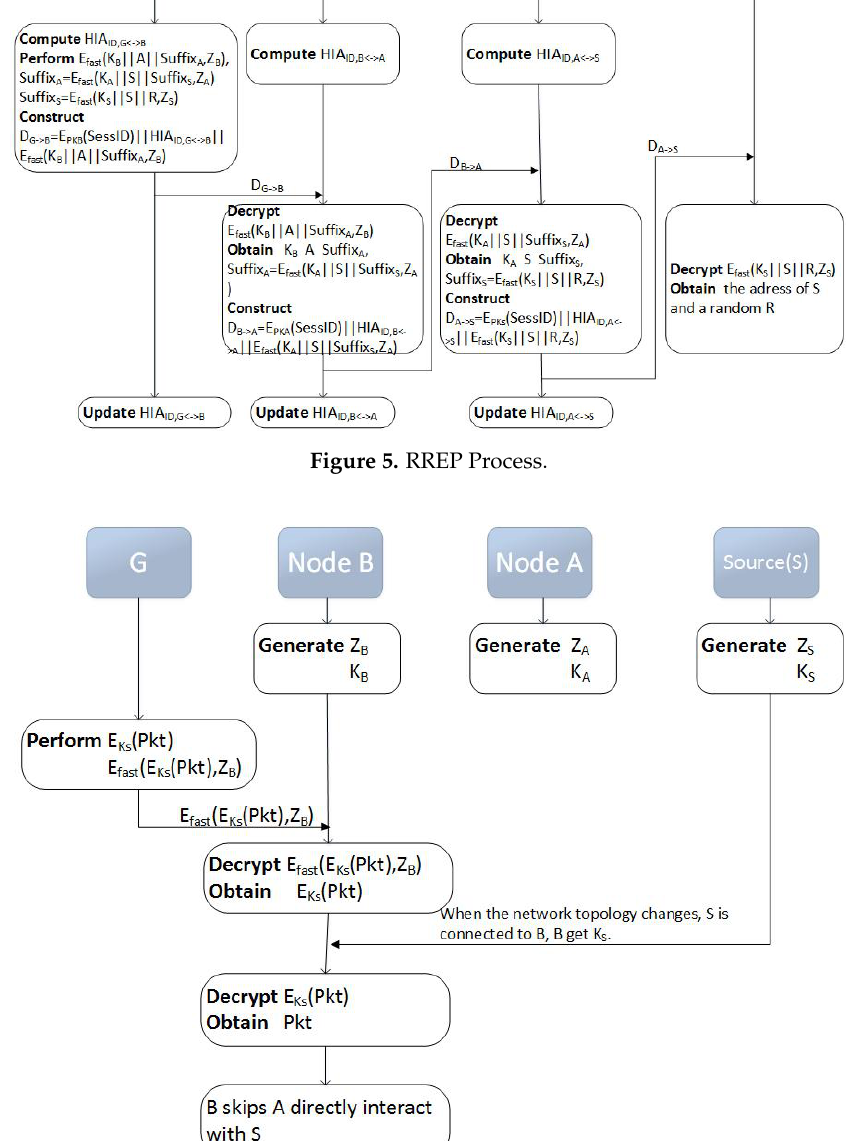
Figure 6. Self-healing Process of Anonymous